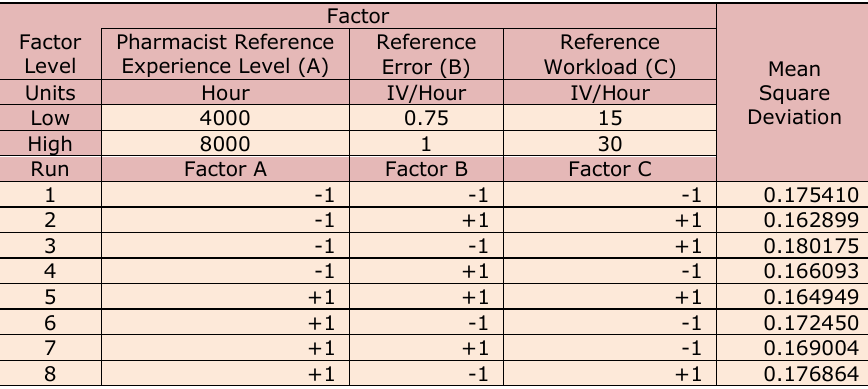
Table 1. Values for the simulation model parameters which has impact on errors in the